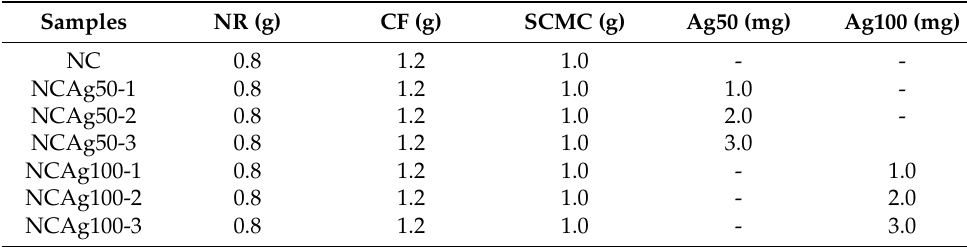
Table 1. Contents of NR, CF, SCMC, and AgNPs in the dried composite films.